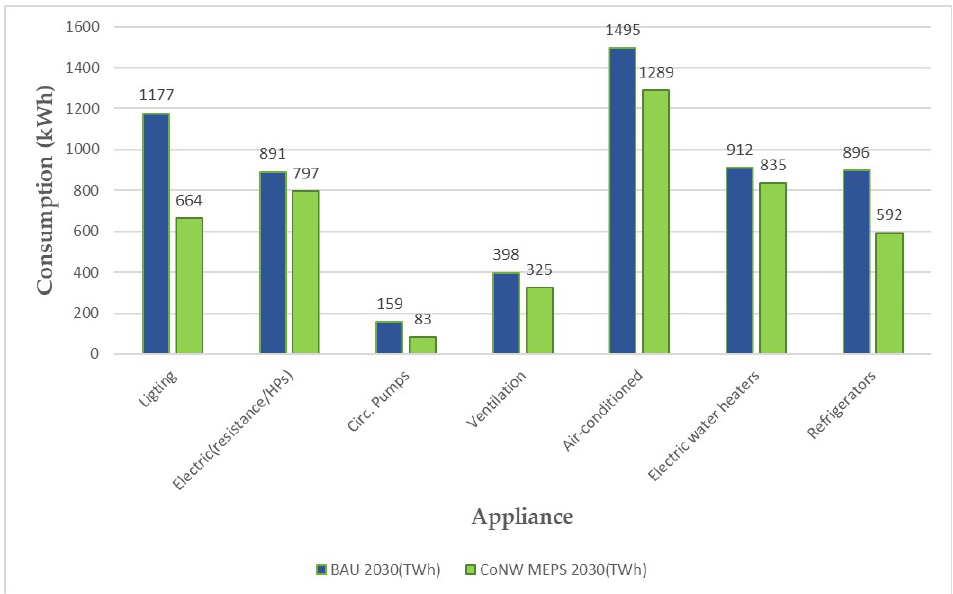
Figure 1. Estimated reduction in refrigeration consumption by applying BAT and MEPS to 2030. Adapted from